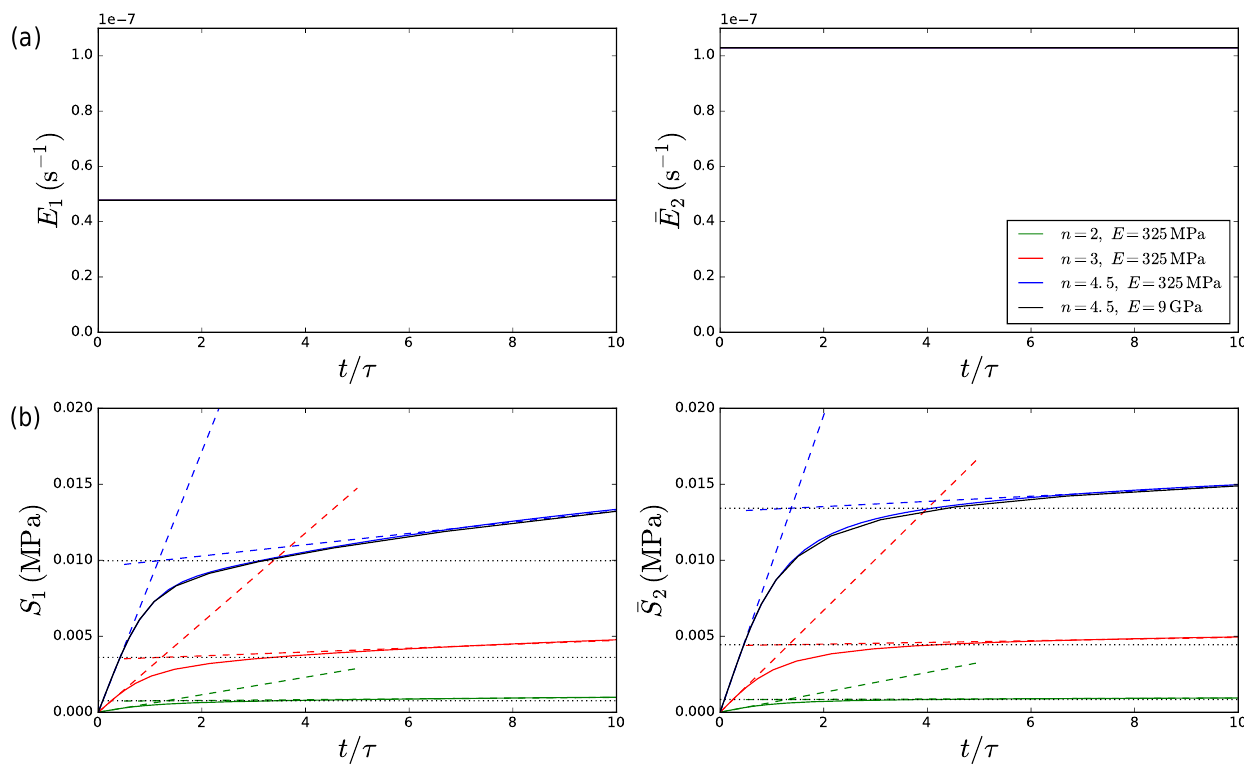
Figure 3. Imposed strain rate (a) and stress response (b) versus dimensionless time ( t/τ ) for the sample RG_1600 (see Table 2). The loading strain rate is characterized by θ = 65 ◦ in Eq. (21). Two Young’s moduli and three values of n are considered.